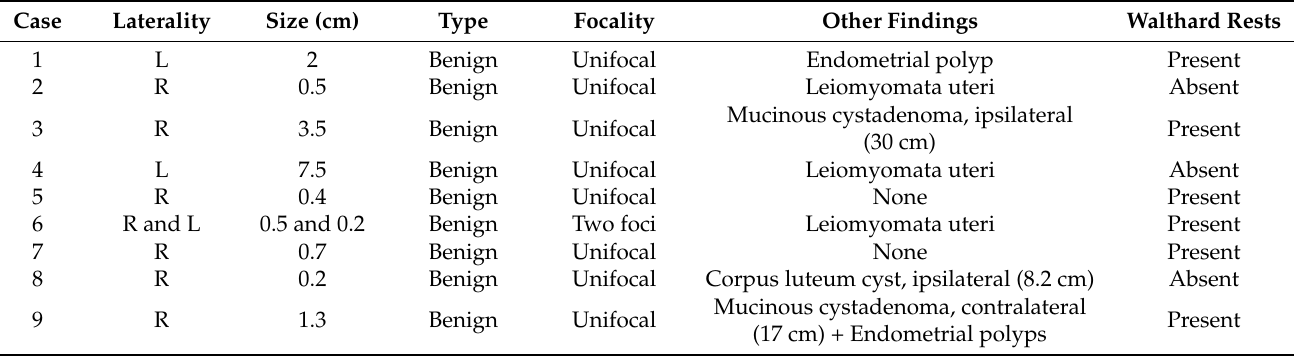
Table 2. Pathological characteristics of all Brenner tumor patients included in our